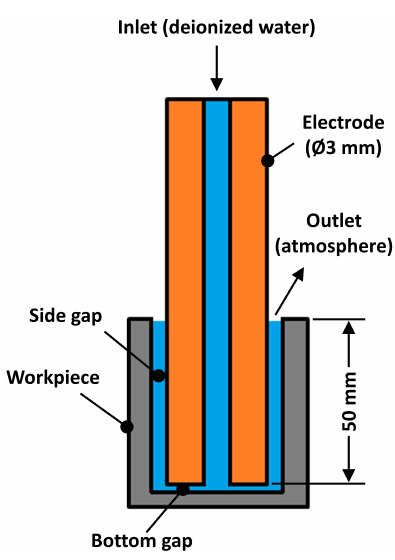
Figure 6. Sketch of setup used for numerical model.